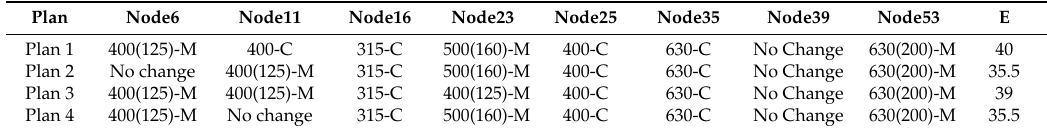
Table 8. Planning schemes of distribution transformers considering load